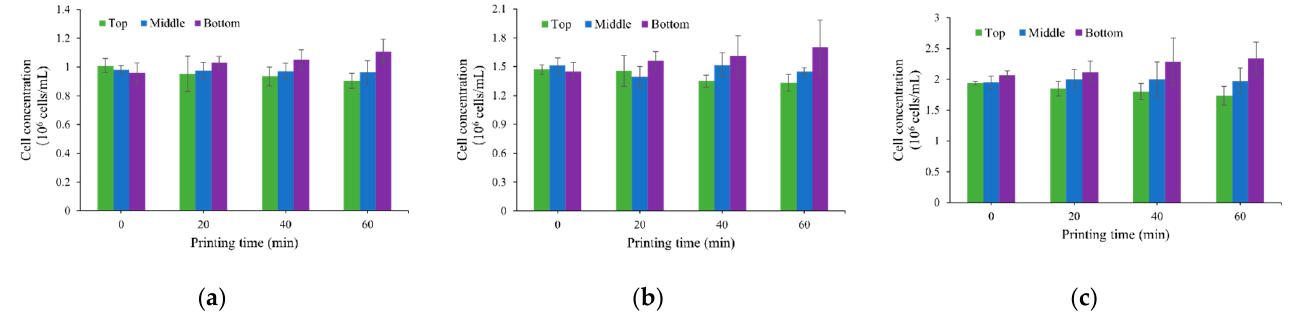
Figure 4. Cell concentrations measured at different regions after different printing time using the bioink composed of 3% ( w / v ) sodium alginate and a cell concentration of ( a ) 1 × 10 6 cells/mL, ( b ) 1.5 × 10 6 cells/mL, and ( c ) 2 × 10 6 cells/mL.